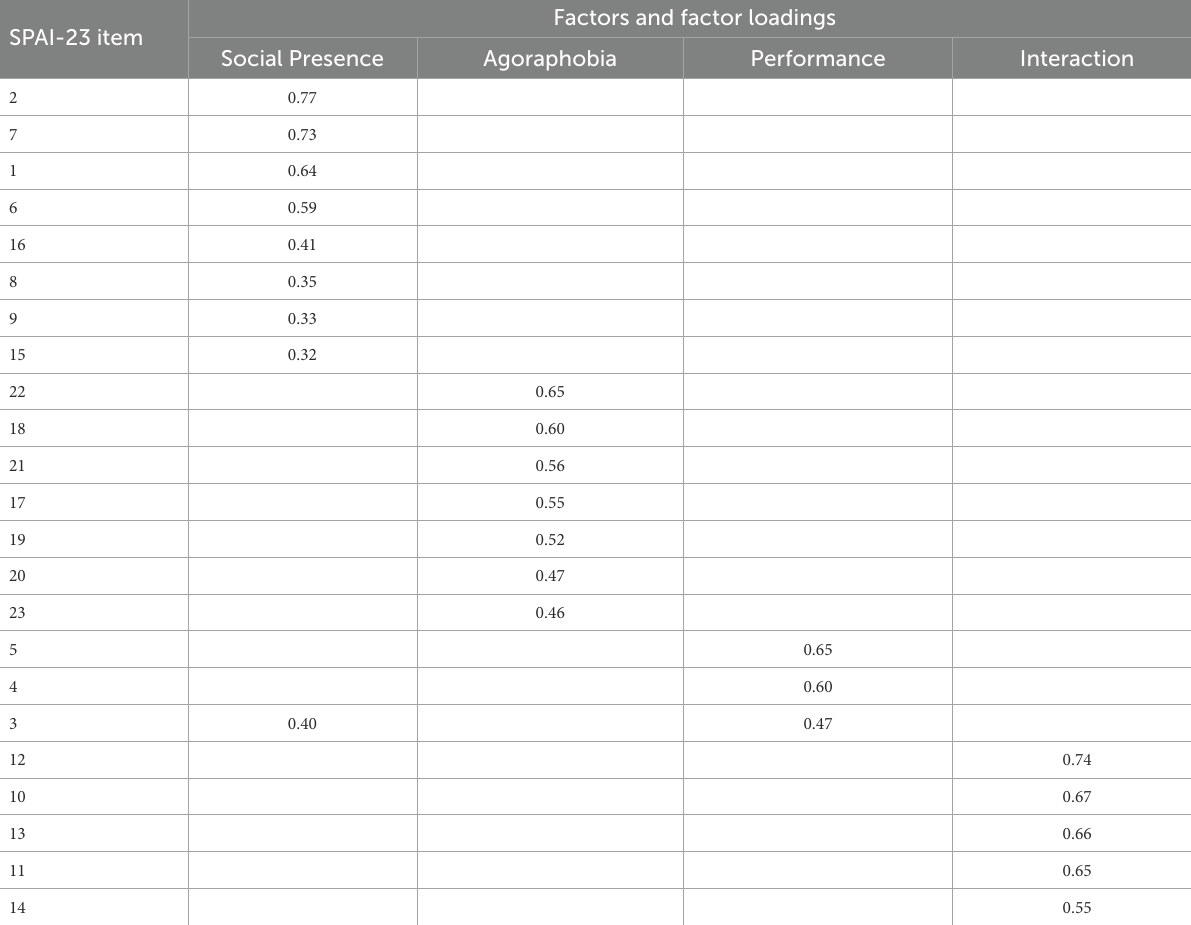
TABLE 4 Results of a four factor solution from unrestricted EFA using principal axis factoring (PAF) and oblique rotation.